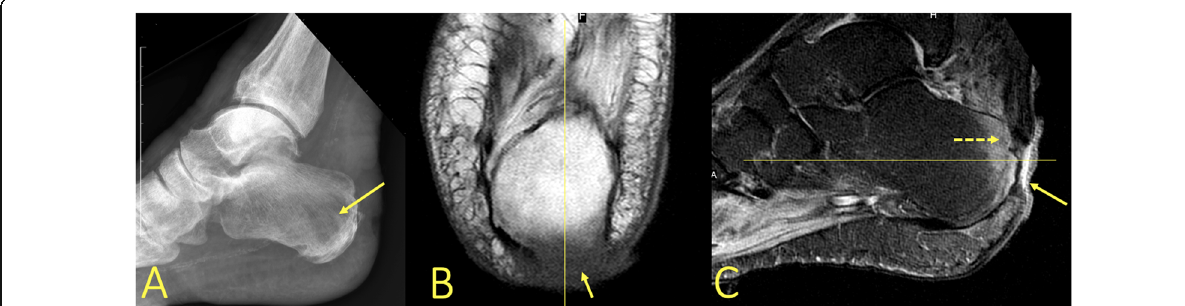
Fig. 27 A 66-year-old male with diabetes. a Osteomyelitis in calcaneus was suspected clinically and on radiographs. b , c MRI confirmed the diagnosis (arrows), BME (dashed